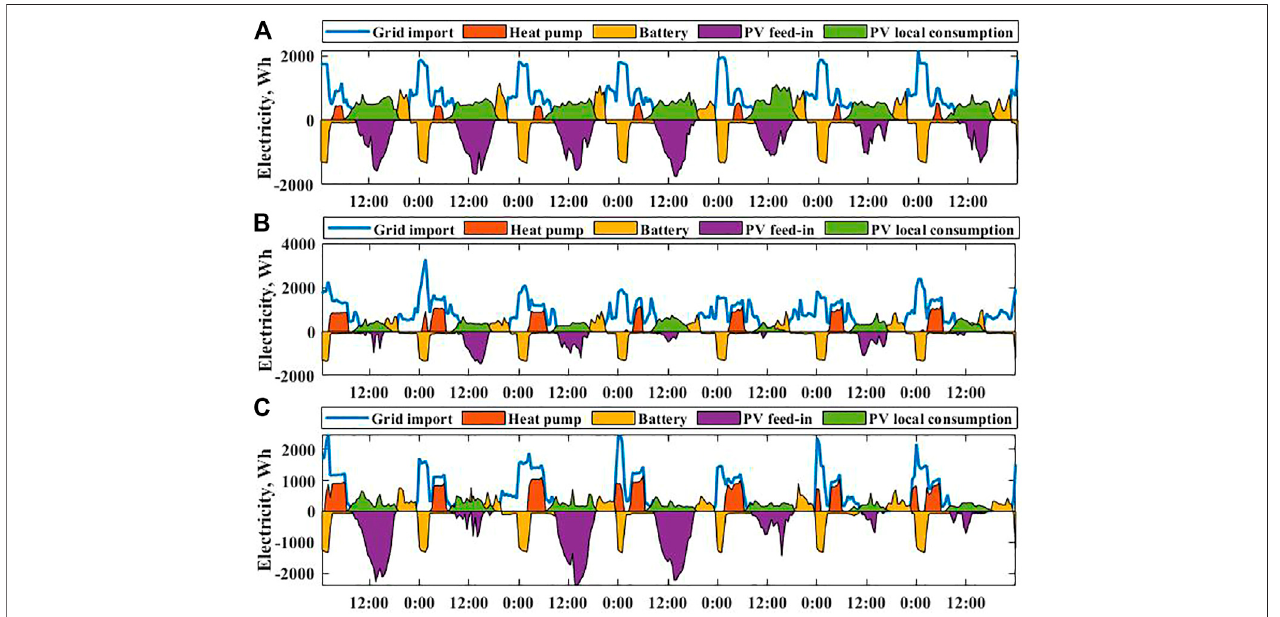
FIGURE 14 | Weekly power fl ows of typical ZEH equipped with PV, battery, and heat pump systems at 30-min intervals in summer from 01 August to 07 August (A) , winter from 01 January to 07 January (B) , and mid-season from 01 to 07 April (C) .